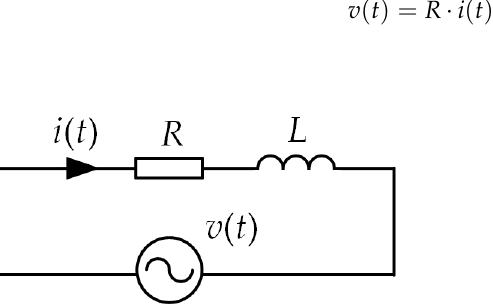
Figure 2. Electrical circuit diagram used to assess the accuracy of the di ff erential equation approxi- mation algorithm.